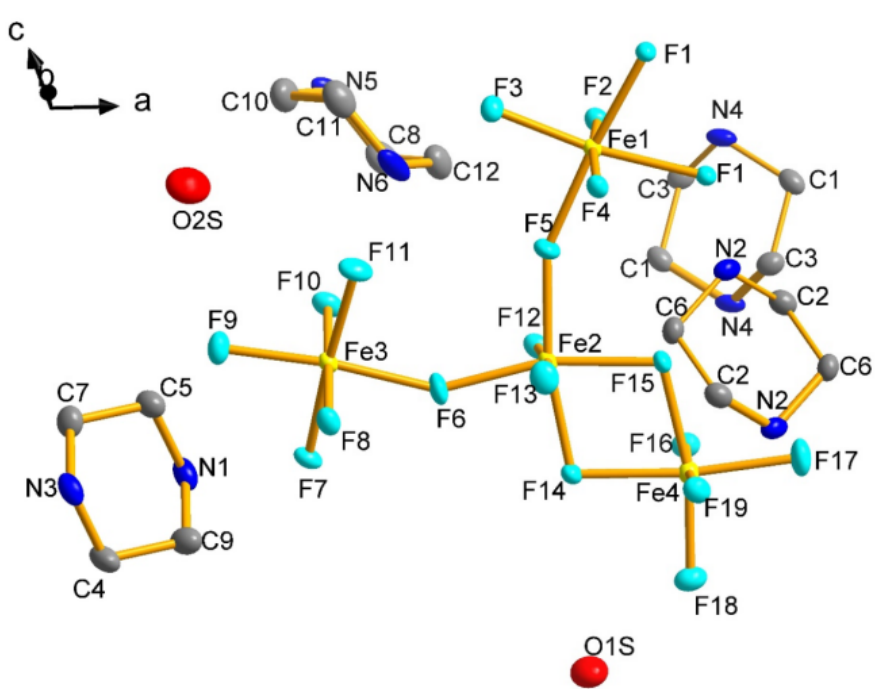
Figure 3. The building unit of 1 (Hydrogen atoms are eliminated for clarity).